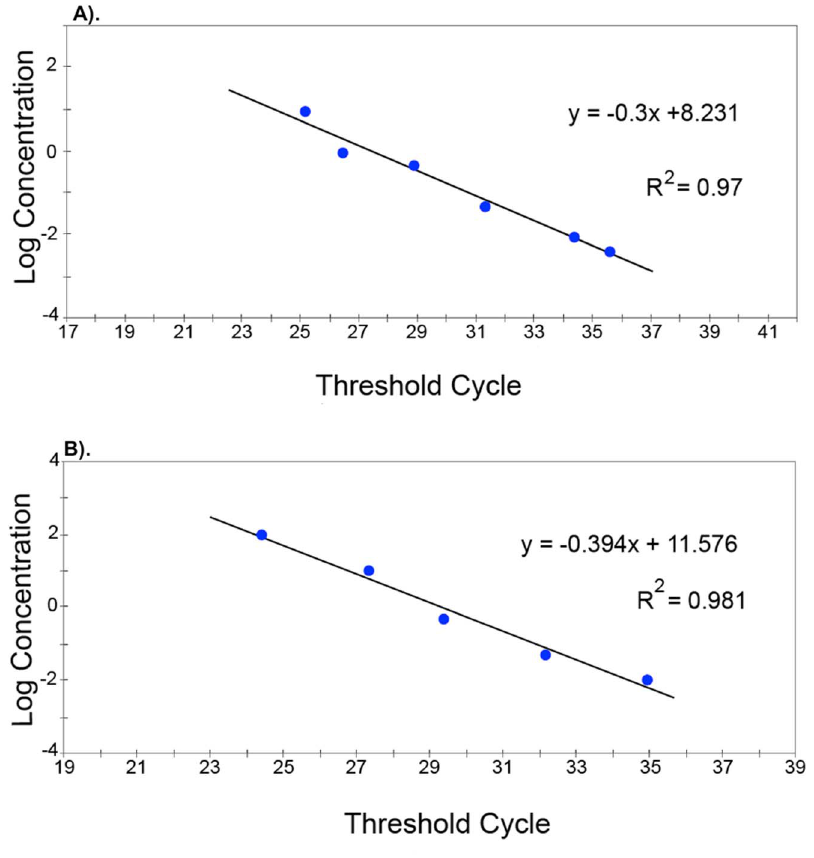
Figure 2. Real-time PCR standard curves. Real-time PCR standard curves showing the linear relationship between the log of known DNA concentrations and the second derivative cycle threshold (C T ) value. C T values represent positive samples when the fluorescent signal crosses the amplification threshold prior to cycle 40. (a). C. cereale clade A probe A-Apn2 with lower detection limit of 4 pg; and (b). C. cereale clade B probe B- Apn2, with lower detection limit of 5 pg. doi:10.1371/journal.pone.0097706.g002 609 cultured C. cereale isolates, only one isolate (KS-DGI12) could showed that no amplicon was produced in any of the reactions not be diagnosed using either of the two real-time assays. (two probes, six replicates). Assessment of KS-DGI12 DNA using Visualization of the KS-DGI12 reactions using gel electrophoresis the NanoDrop spectrophotometer showed an overabundance of